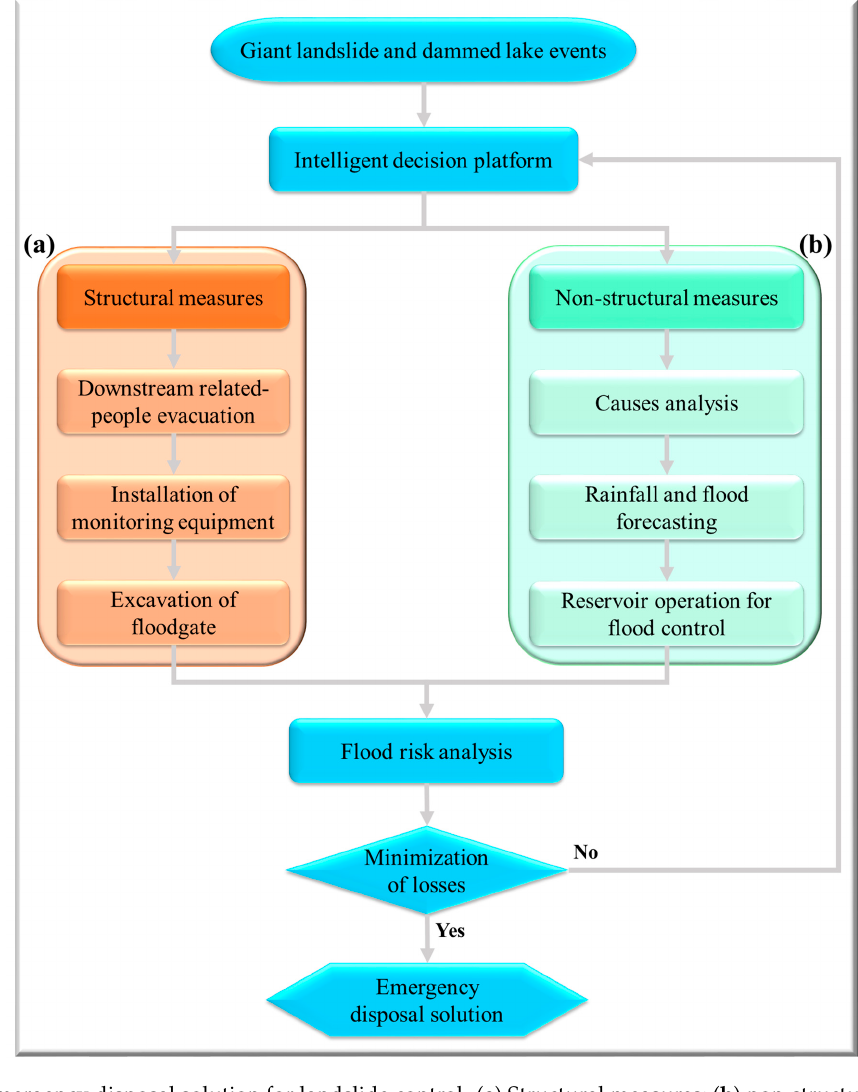
Figure 2. Emergency disposal solution for landslide control. ( a ) Structural measures; ( b ) non-structural measures.